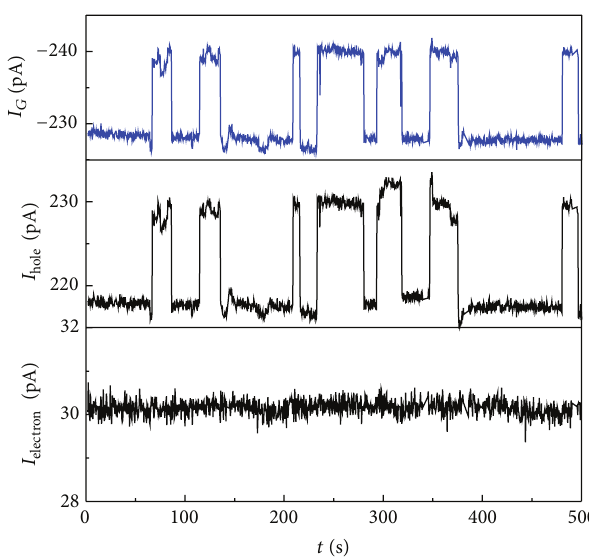
Figure 3: The time traces of gate current, electron current, and hole current under NBT stress ( − 1.9V) at 𝑇 = 320 K by using carrier separation